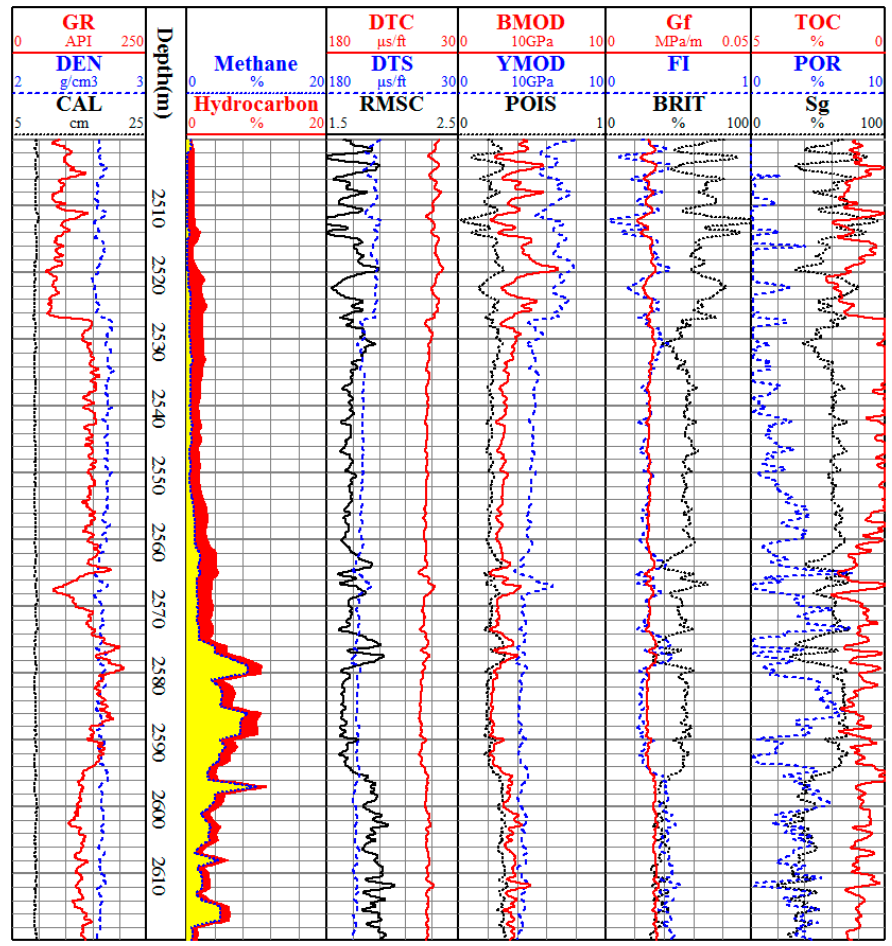
Figure 10. The presentation log for rock mechanics in the horizontal section (2500.0–2620.0 m) of Well